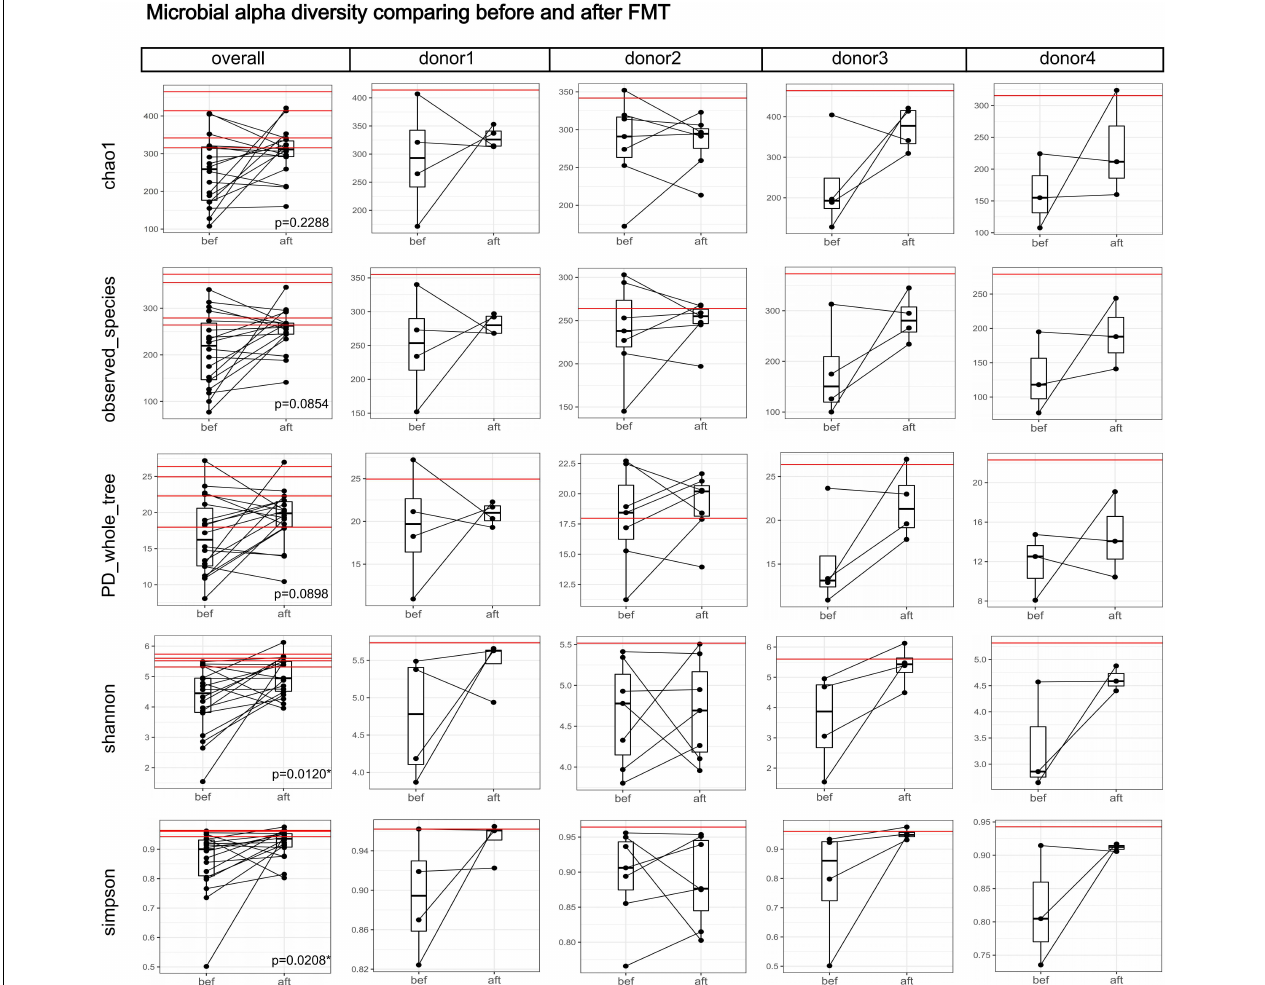
FIGURE 1 | Boxplots comparing the gut microbial alpha diversities before and after FMT. Each black dot represents one sample (patient); pre-FMT and post-FMT samples from the same patient are connected by a black line. Each red horizontal line represents one donor. The “overall” column shows the alpha diversity indexes of the 18 patients and four donors, and the significance test between the before and after groups was a paired-samples Wilcoxon-test (“*” indicates 0.01 ≤ p < 0.05). The Shannon and Simpson indexes increased significantly after FMT. Columns for each donor show the alpha diversity changes in each donor-recipient pair. We did not perform separate significance tests on each donor-recipient pair because of the small sample size.